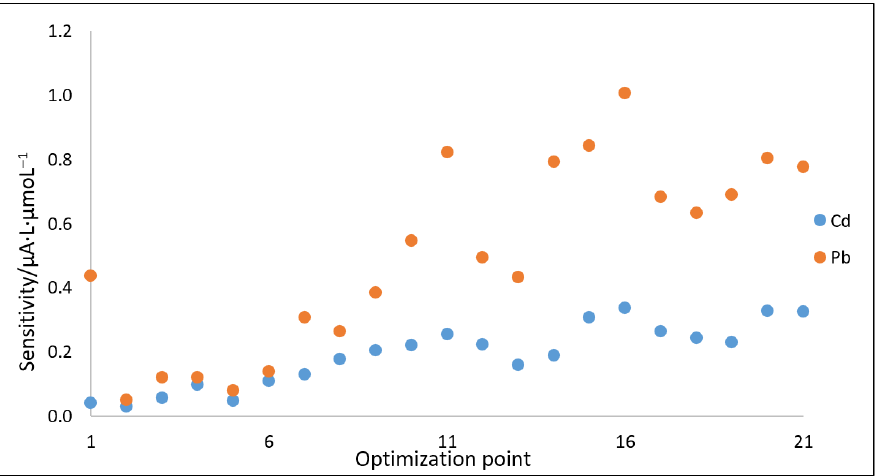
Figure 6. Change in sensitivities obtained from calibration dependencies during optimization process (for details see text above and Table S2 in Supplementary